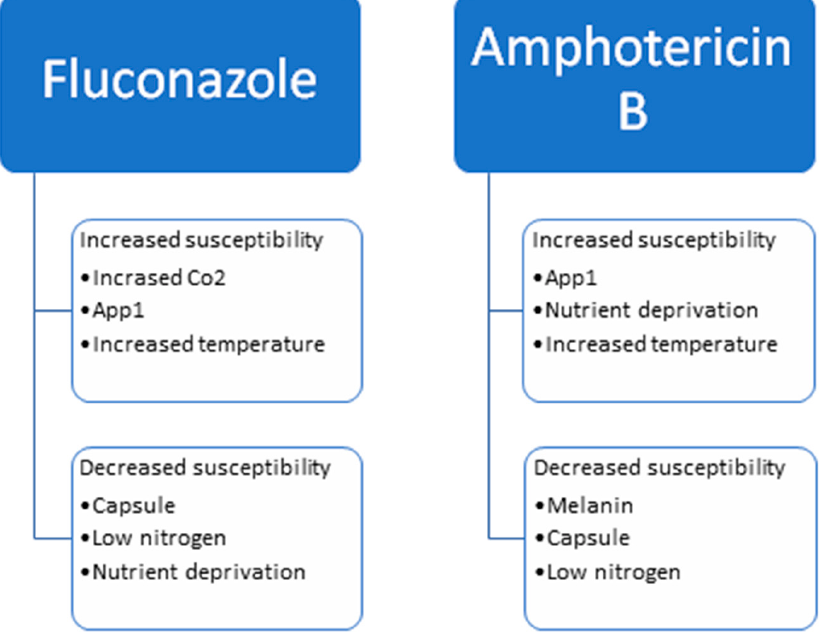
Figure 2. Factors that influence the susceptibility of Cryptococcus neoformans to fluconazole and amphotericin B.